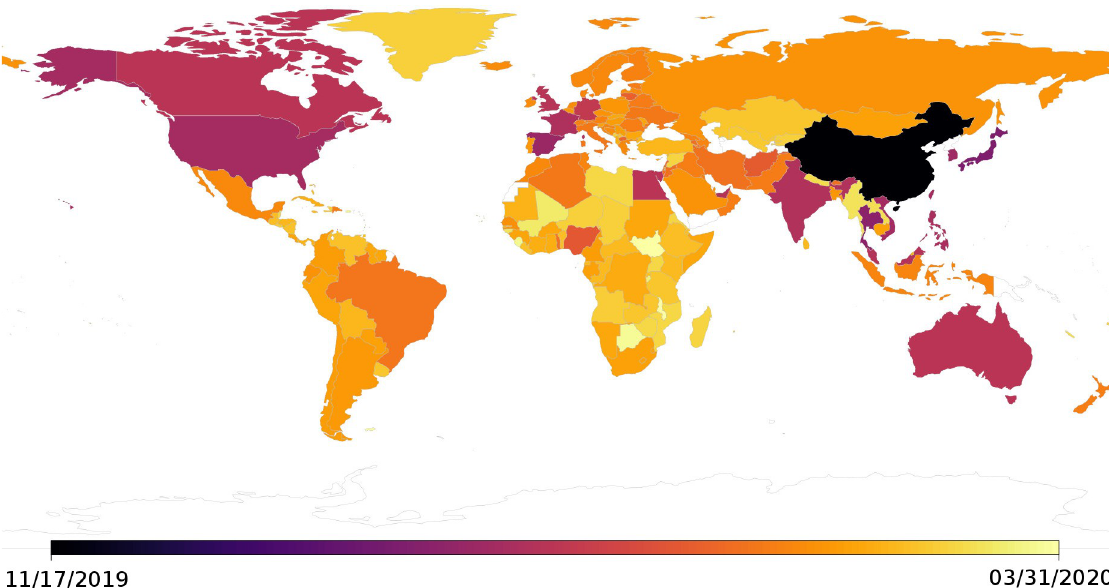
Fig 2. Map of the estimated origin dates per country. Map layers were created using the R package rworldmap, Version 1.3–6 (http://cran. r-project.org/web/packages/rworldmap).